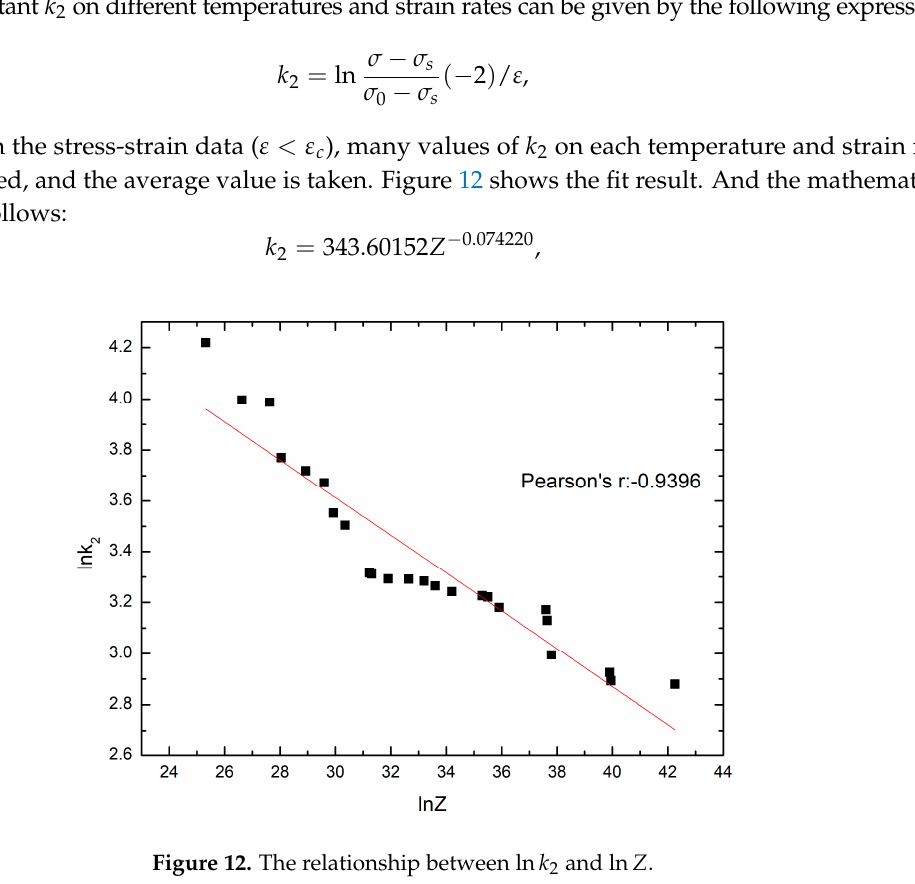
ln k and ln Z . 2